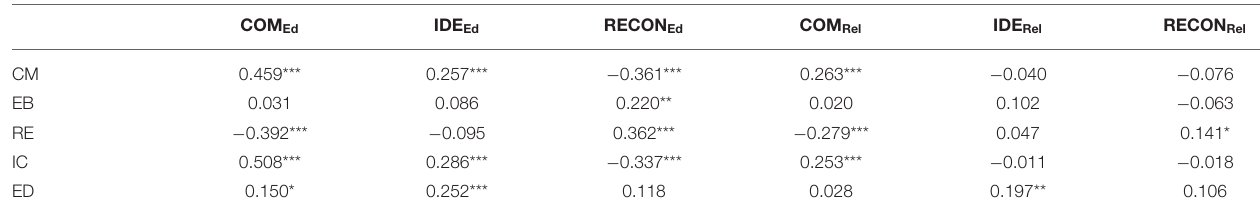
TABLE 9 | The relationship between the five dimensions of H-DIDS and the six dimensions of H-UMICS (educational and relational identity); results of Pearson’s